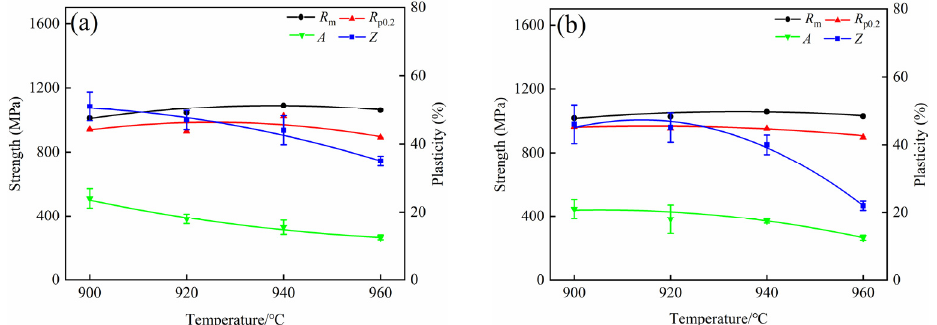
Figure 10. Tensile properties after BASC and BASCA heat treatment: ( a ) BASC heat treatment; ( b ) BASCA heat treatment.